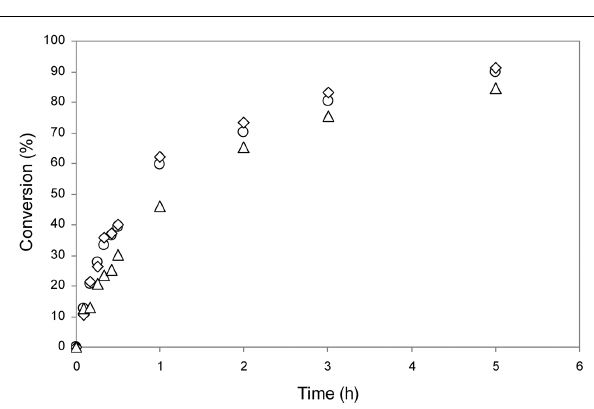
applied for this purpose with low productivities (Ferrer et